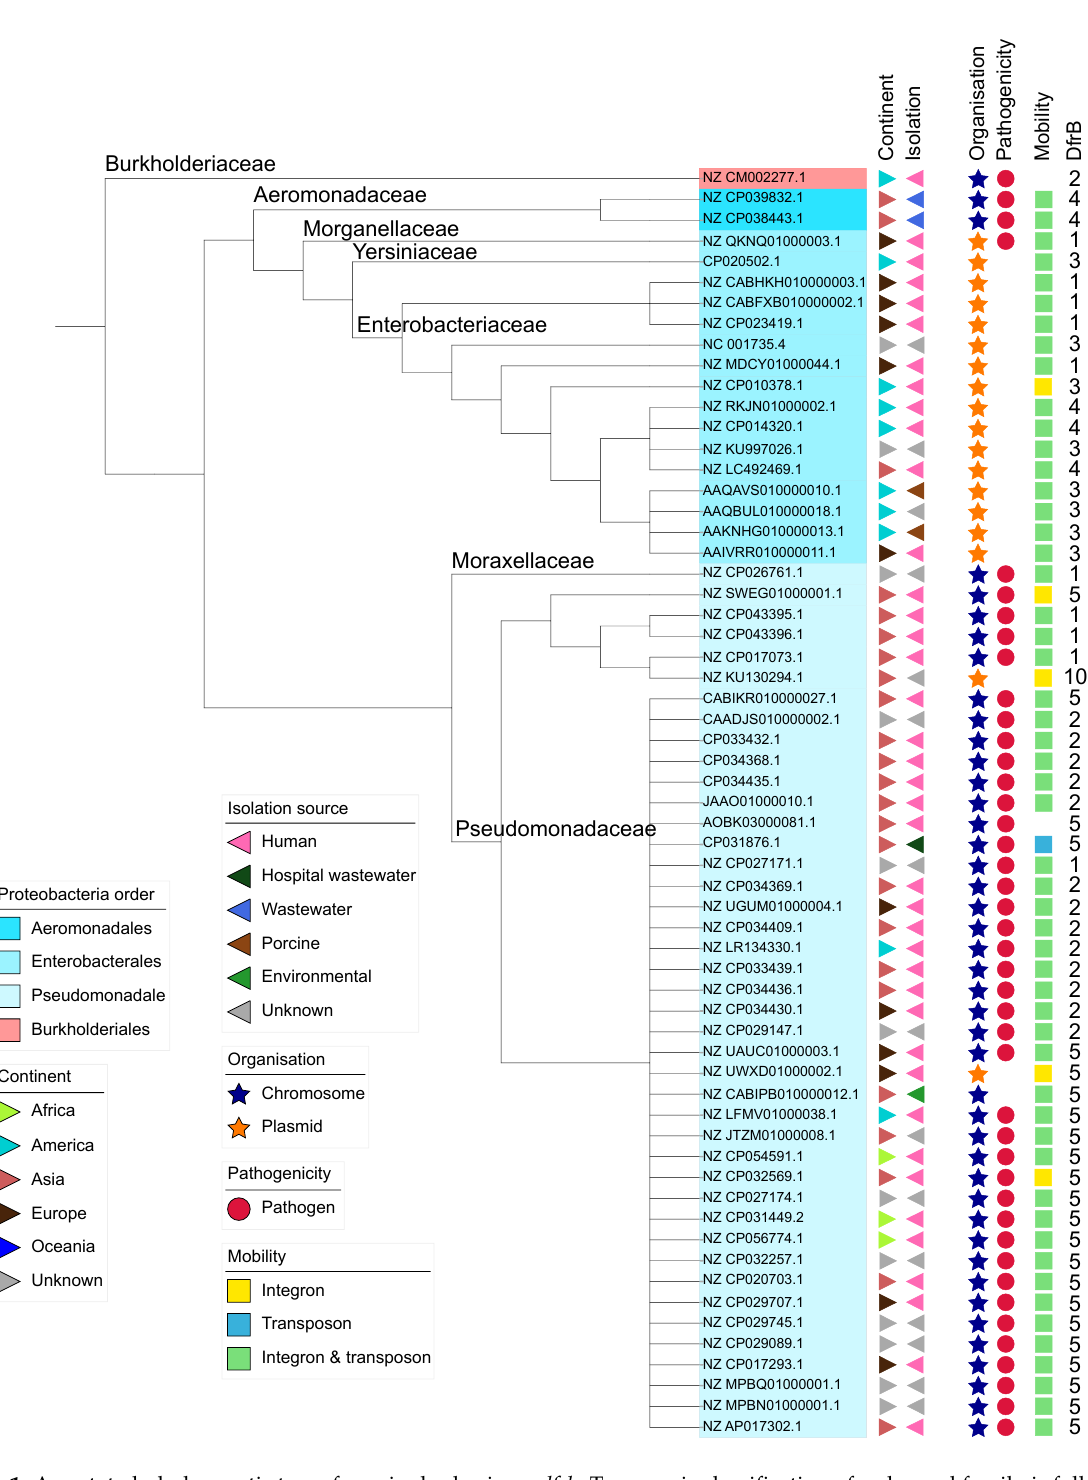
Figure 1. Annotated phylogenetic tree of species harboring a dfrb . Taxonomic classification of order and family is followed by categorization according to GenBank information on the strain’s isolation source and country of isolation. Sequences are further categorized as being located in a chromosome or a plasmid, pathogenicity of the host organism and information on mobile genetic elements. The dfrb gene member identified in each sequence is specified (i.e., “2” indicates dfrb2